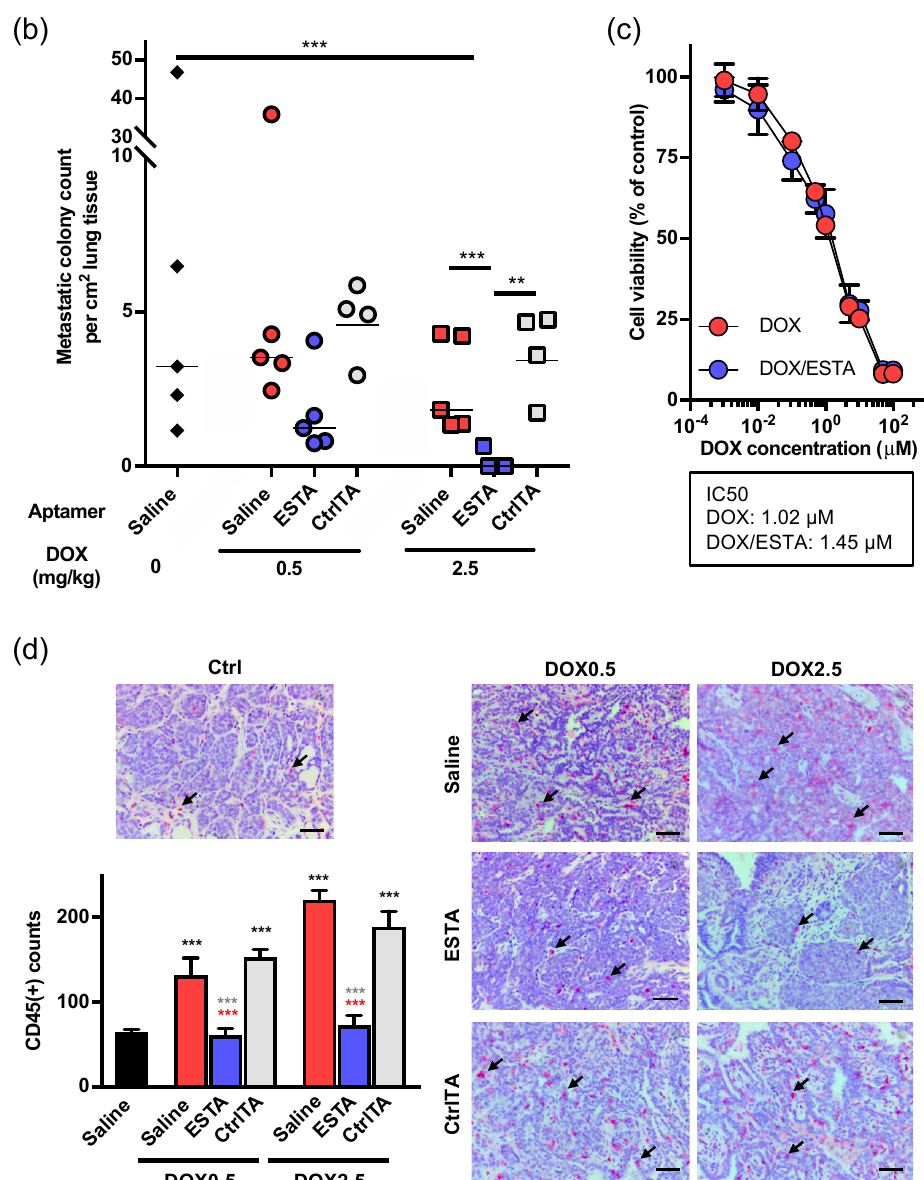
Figure 3. The e ff ect of ESTA on DOX therapy. ( a ) Tumor growth in MMTV-PyMT mice. Mice ( n = 6) were treated with DOX (0.5 or 2.5 mg / kg), DOX / ESTA, or DOX / CtrlTA for 2 weeks as depicted in the timeline. The graph shows fold change of tumor growth (0 days / treatment starting point as 1 of each group at days 0, 7, and 14. ( b ) The e ff ect of ESTA / DOX combination on lung metastases. Step sections of the whole lung were stained with H&E and metastatic foci sizes of > 50 µ m φ were counted and normalized by total area (cm 2 ). ( c ) The e ff ect of ESTA on IC50 of DOX. Py8119 cells were incubated with various concentration of DOX (0.001, 0.01, 0.1, 1, 10, 100 µ M) with saline or ESTA (100 nM) for 24 h. Cell viability was measured by MTT assay ( n = 6). The viability of saline-treated cells was 100%. IC 50 was calculated by four parameter logistic curves. ( d ) Immunohistochemistry of CD45. Tumors were stained with CD45 (red) and counterstained with hematoxylin (blue). Arrows indicate CD45 + cells. The bar graph depicts mean ± SE, and statistical significance was analyzed by the Mann Whitney test. Scale bar indicates 50 µ m. Graph is depicted as mean ± SE (a, b) or ± SD (d). Statistical significance was analyzed by the Mann Whitney test. * p < 0.05; ** p < 0.01; *** p <